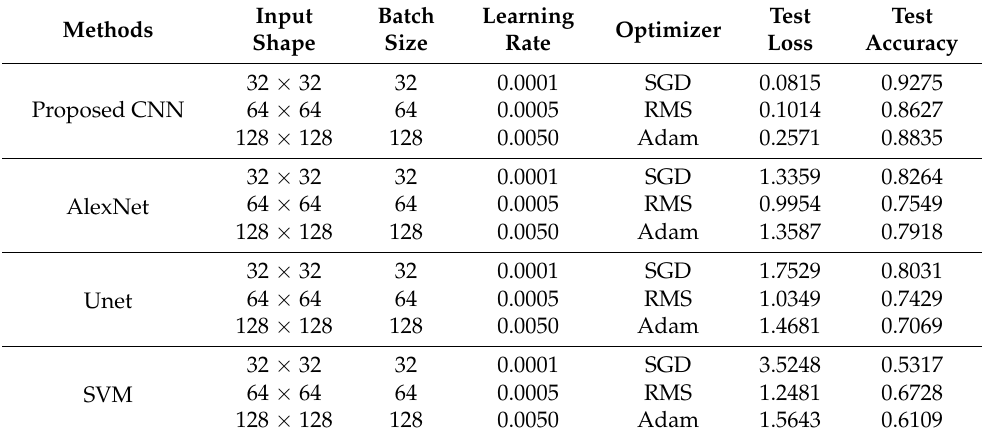
Table 3. Test accuracy under different